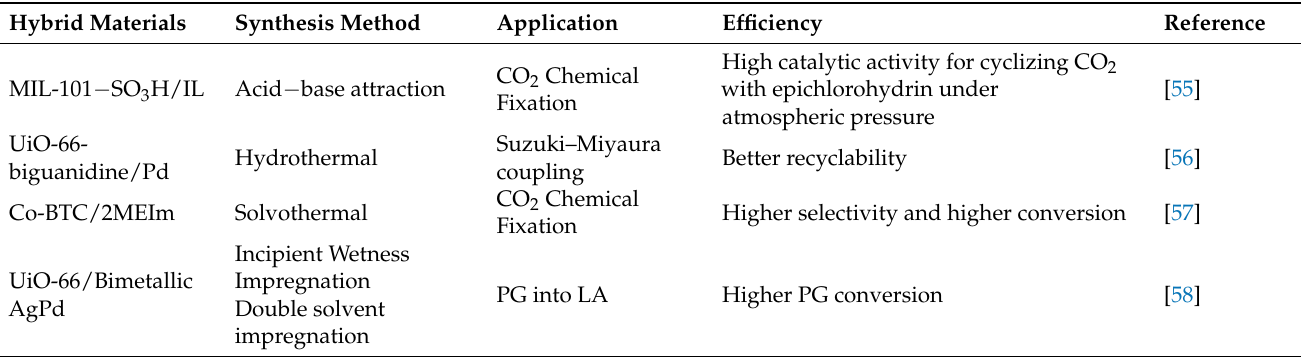
Table 2. Summary of catalysis applications in hybrid